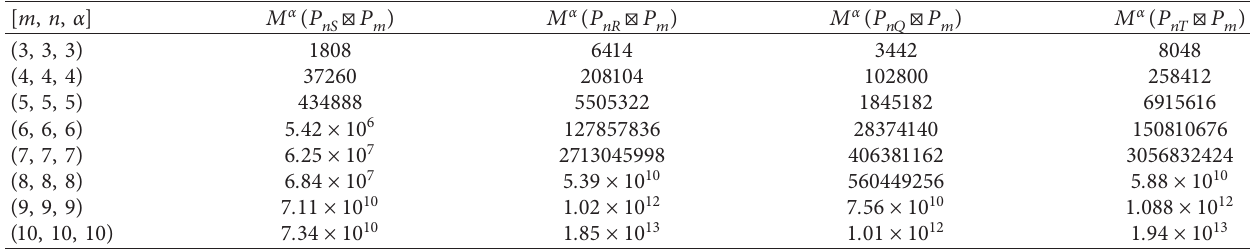
Table 1: Table for Example 1.